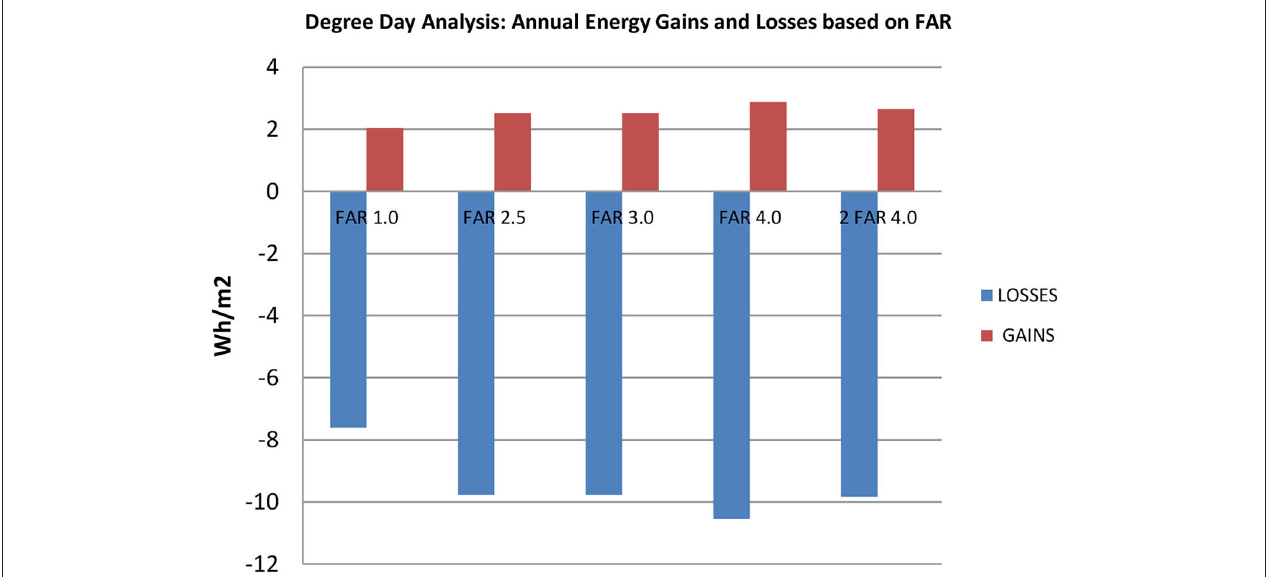
FIGURE 10 | Degree day analysis—annual energy gains and losses based on FAR (y-axis: annual energy gains and losses in Wh/m 2 ; x-axis: FAR variations, including second model of FAR 4.0).